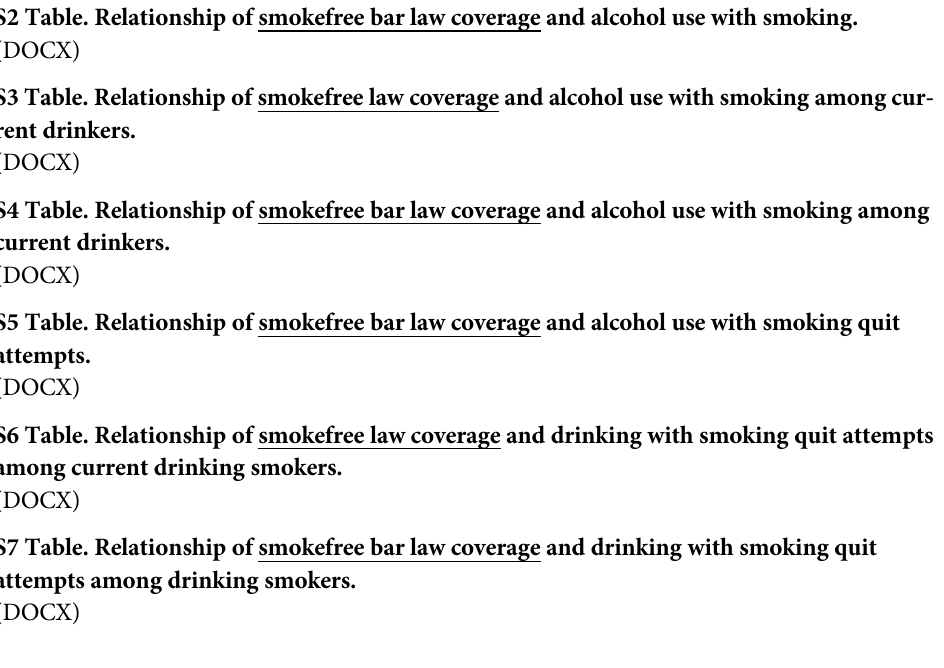
S1 Table. Sample characteristics. S2 Table. Relationship of smokefree bar law coverage and alcohol use with smoking. S3 Table. Relationship of smokefree law coverage and alcohol use with smoking among cur-